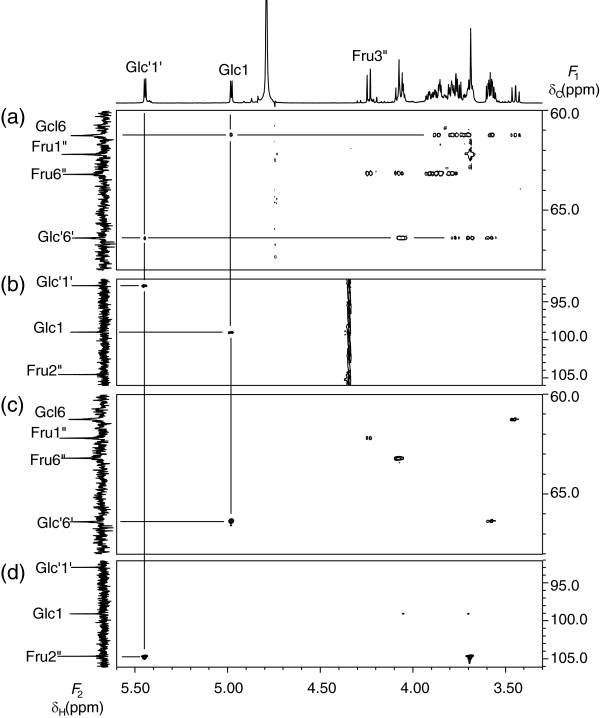
Selected parts of the HSQC-TOCSY (a), HSQC (b), HMBC (δC60.0 ppm ~ 67.0 ppm ) (c), and HMBC (δC92.0 ppm ~ 106.0 ppm) (d) spectra of saccharide 3.